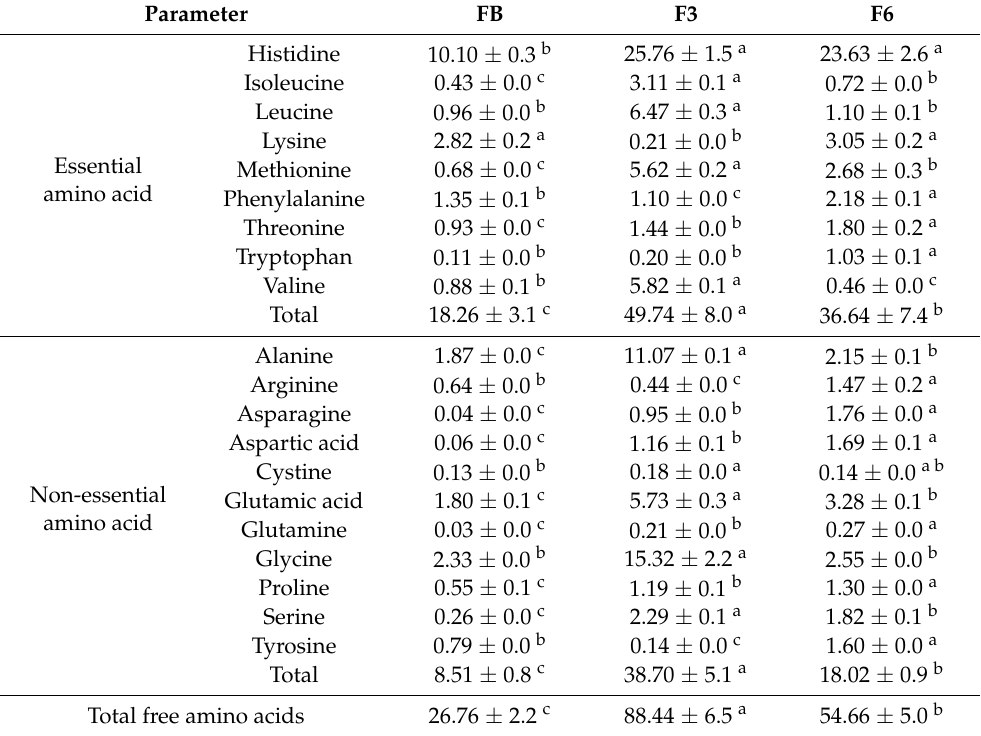
Table 2. Free amino acid composition analysis (mg/100 mL) of FB, F3, and